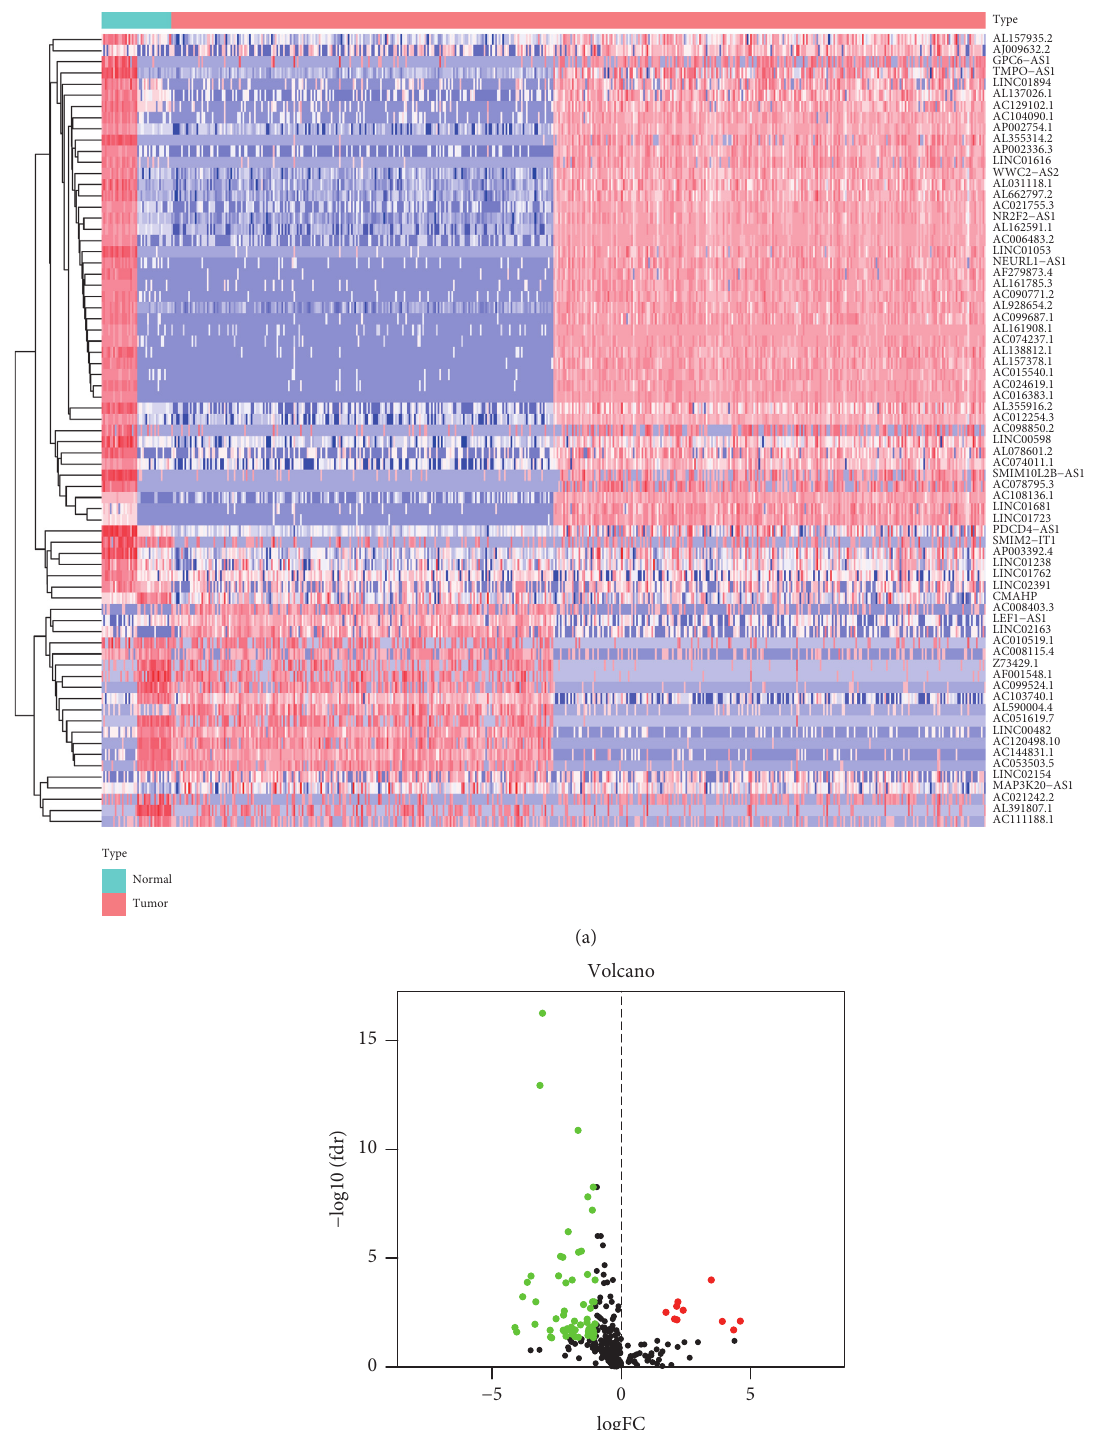
Figure 2: (a) Heatmap of the 71 upregulated and downregulated DEirlncRNA in colon cancer. (b) Volcano plot representing the DEirlncRNA of colon cancer. Upregulated DEirlncRNAs were represented by red dots, and downregulated DEirlncRNAs were represented by green